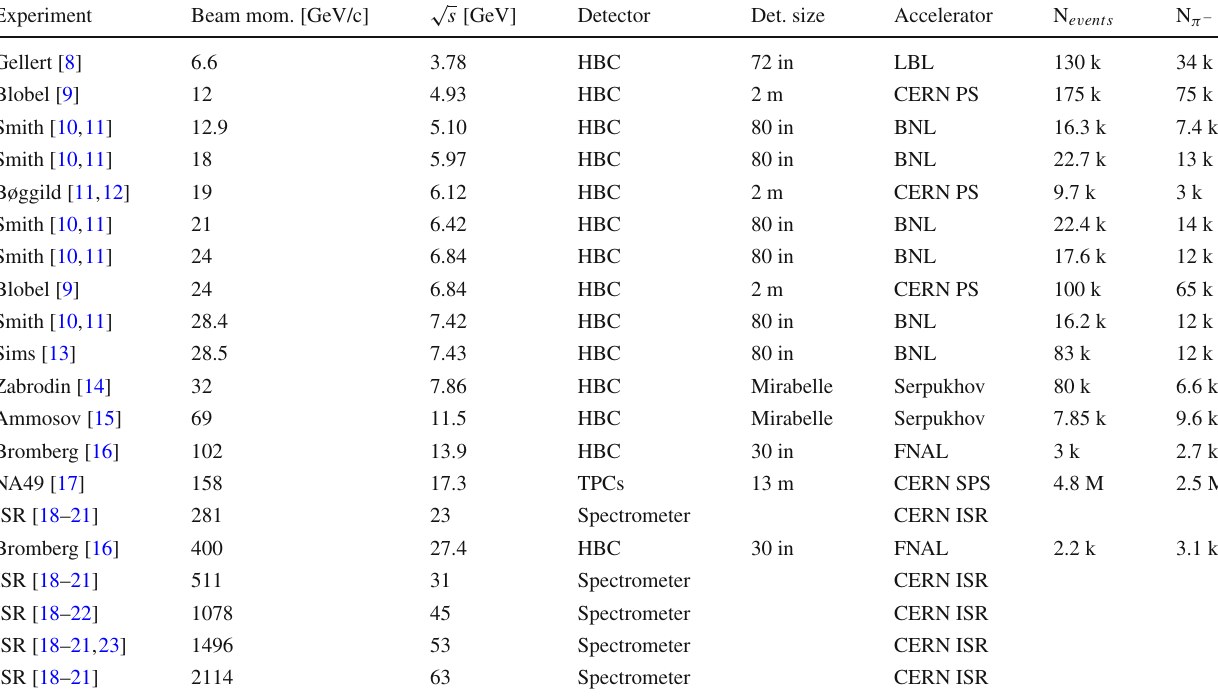
Table 1 Reference experiments